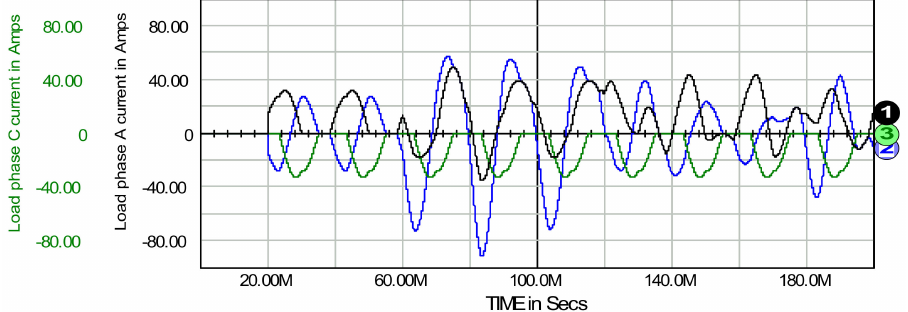
Figure 8. Load phase currents of phase A, B, and C as waveforms 1, 2, and 3, respectively.